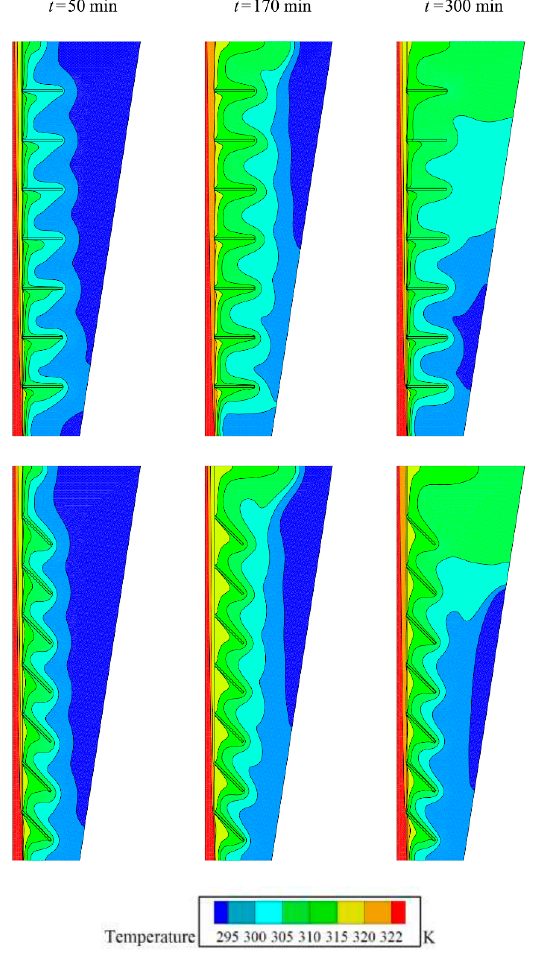
Figure 8. Effect of angle of fins (rad) ( α ) on the contours of isoterm, (Top row) Optimum case with α = 0, and (bottom row) Case 5 with α =-0.25 π for υ na = 0.04, and AR = 0.675.